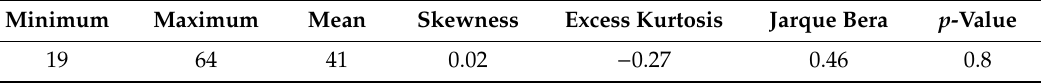
Figure 1. Irish o ffi cial suicide statistics and Irish unemployment records. The remaining y-axis scales represent the number of occurrences. The x-axis represents the date in respect of each data point. Table 2. Normality analysis results for o ffi cial suicides figures. The results suggest that the data follows a normal distribution. The significance threshold used was